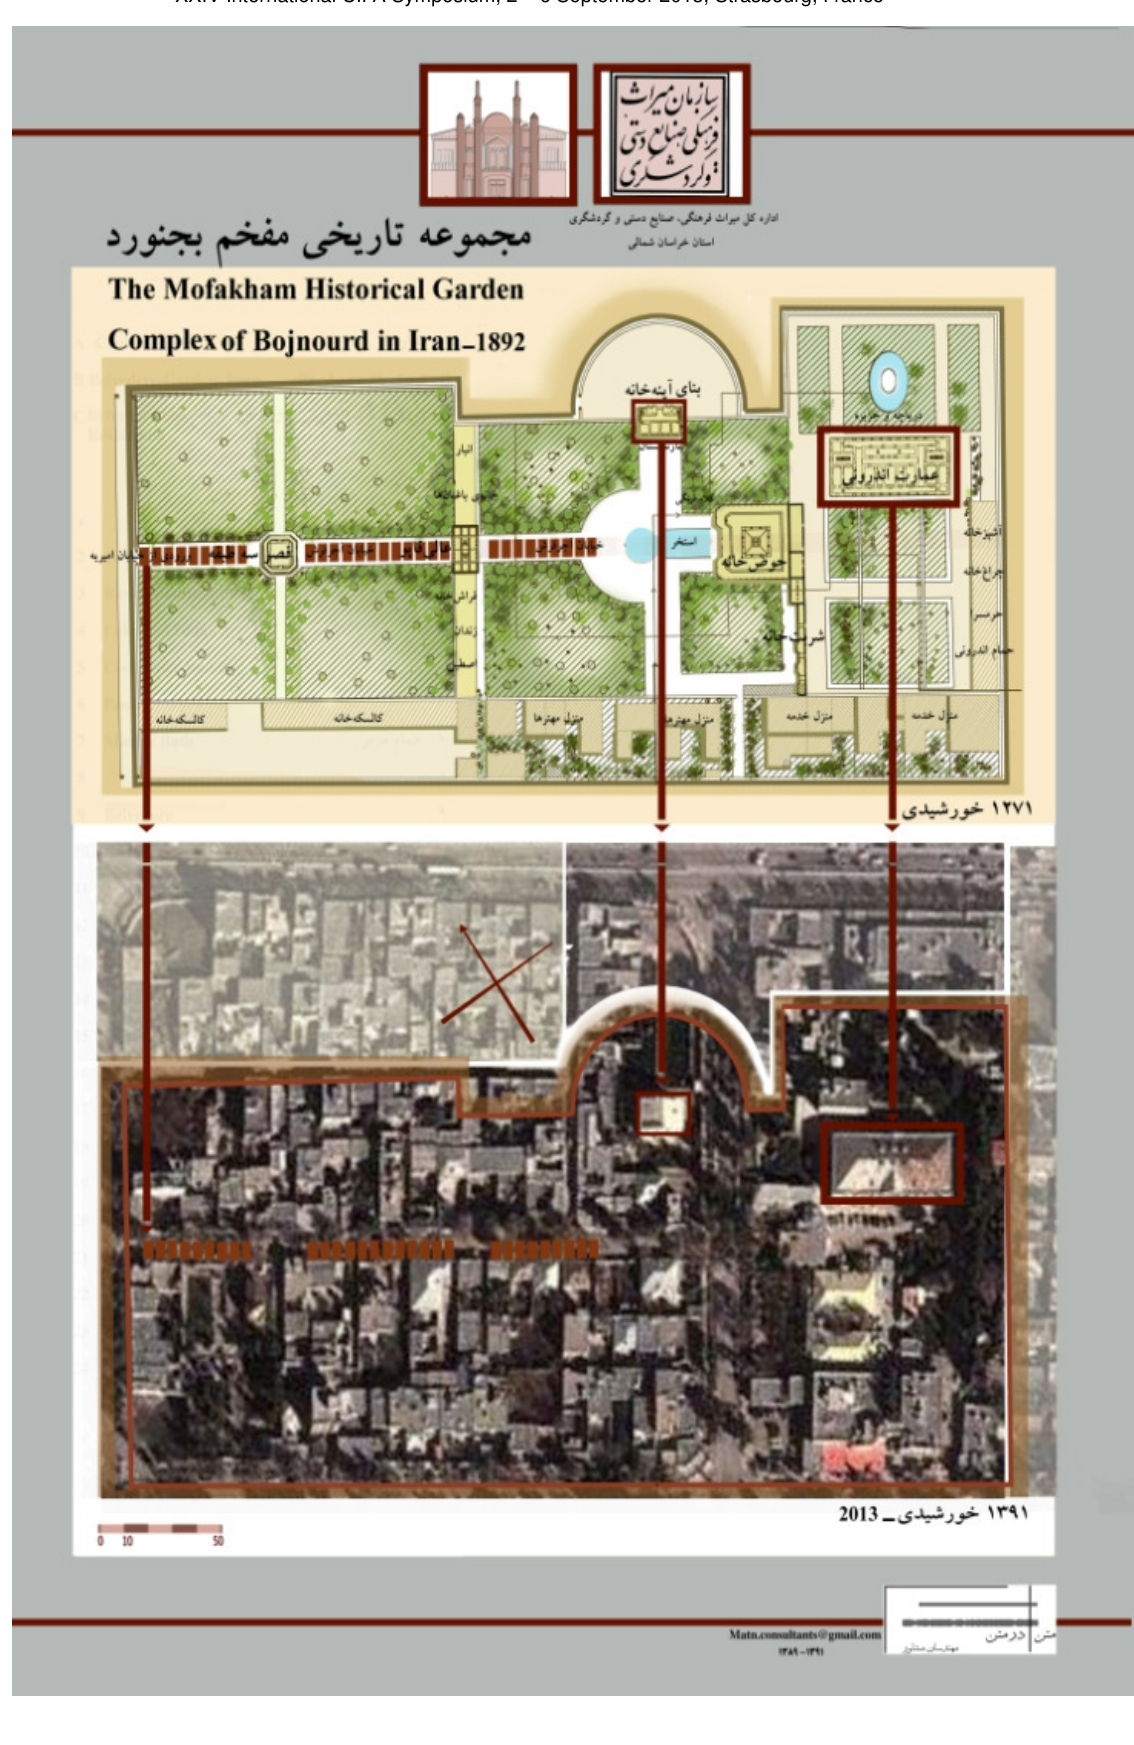
Figure 1: Comparison of Mofakham complex in 1892 and